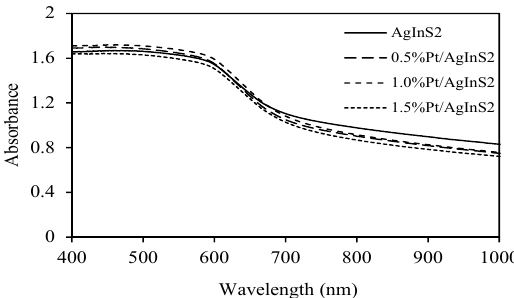
Figure 3. UV–vis diffuse reflectance spectra of AgInS 2 and Pt/AgInS 2 photocatalysts.